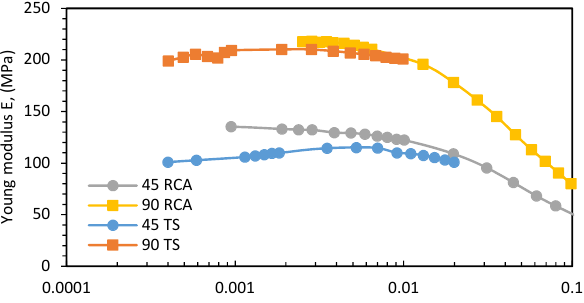
Figure 6. Young modulus E max versus shear strain amplitude for isotropically ‐ consolidated sandy clay ( σ ’ 3 = 45 kPa and σ ’ 3 = 90 kPa); RCA—resonant column test; TS—torsional shear test for a frequency of 1 Hz.